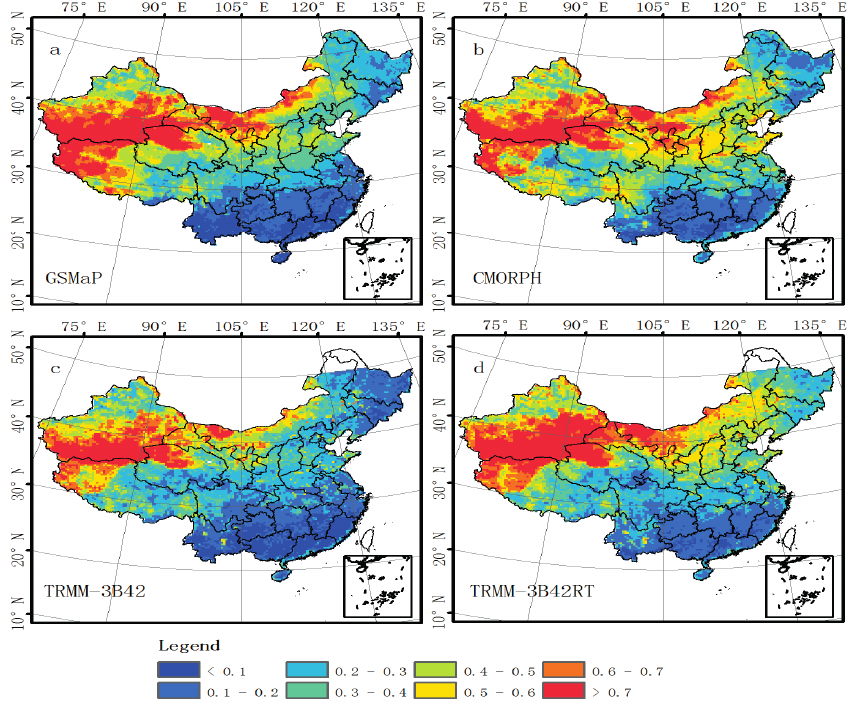
Figure 10. Distribution of FAR over the Chinese Mainland from 2003 to